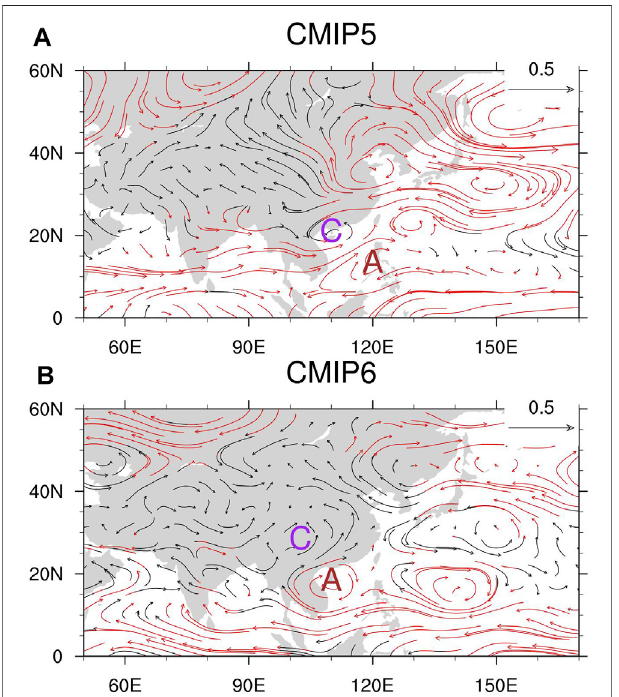
FIGURE7| Thechangesofthe850 hPaU,Vwindanomaly(m/s) during strong EP events in the following summer for CMIP5 ( A . RCP8.5-historical) and CMIP6 ( B . SSP5-85-historical) MME results, with the red vectors exceeding the 95% con fi dence level. Letters “ A ” and “ C ” represent the changes of anticyclone anomaly and cyclone anomaly, respectively.